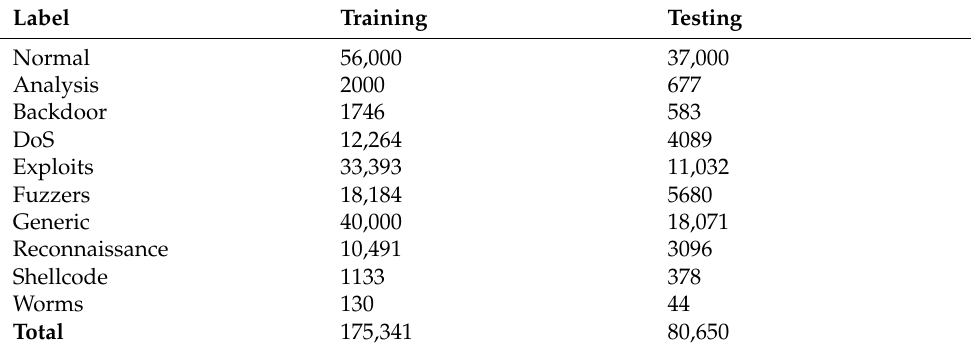
Table 3. Distribution of data on UNSW-NB15 (the number of packets).